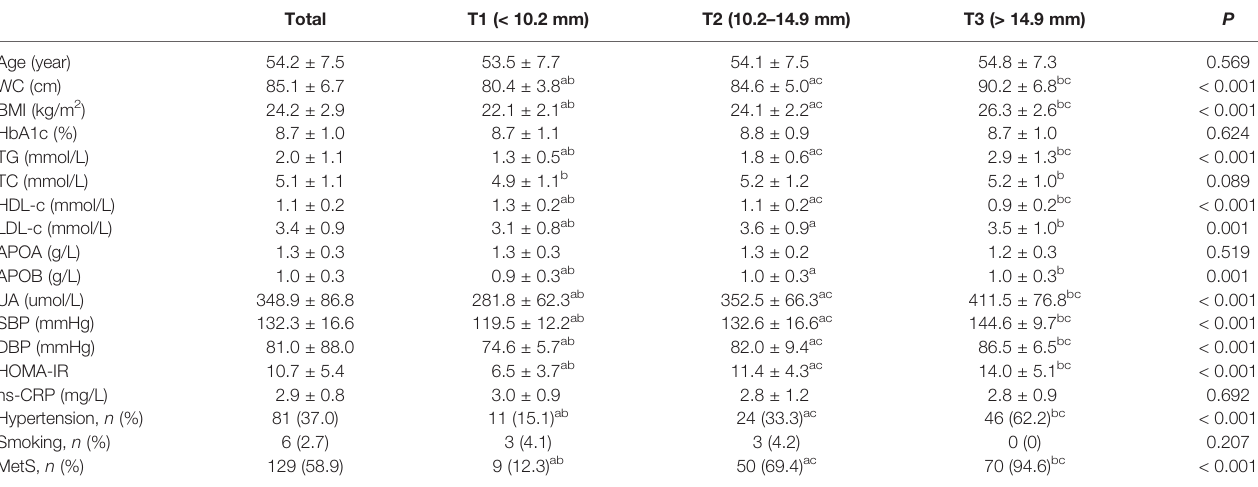
TABLE 2 | The characteristics of newly diagnosed T2DM were divided into three groups based on tertiles of PrFT in women.